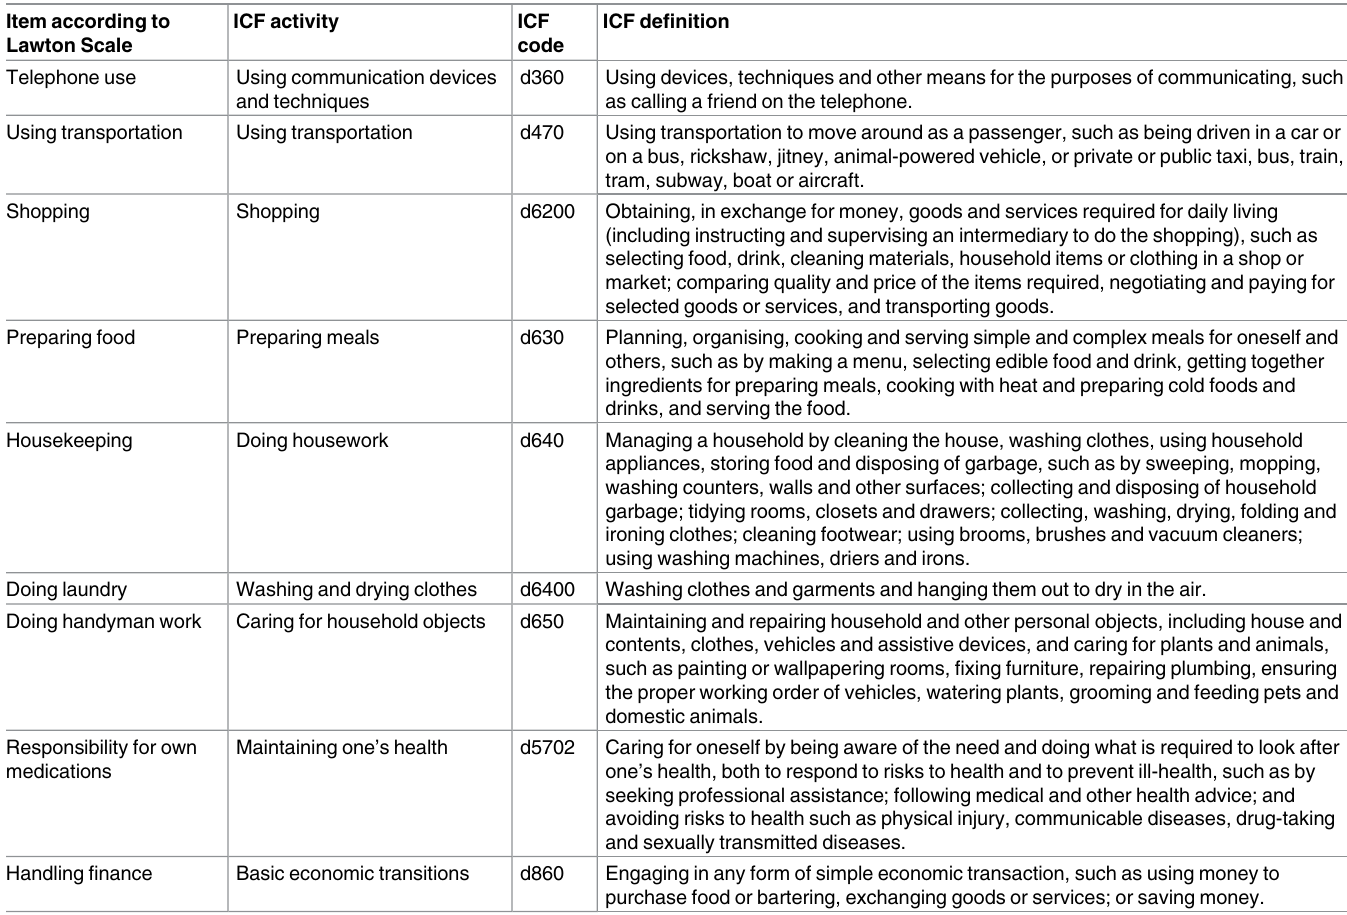
Table 2. Items of the Lawton Scale according to the codes and definitions of the ICF.